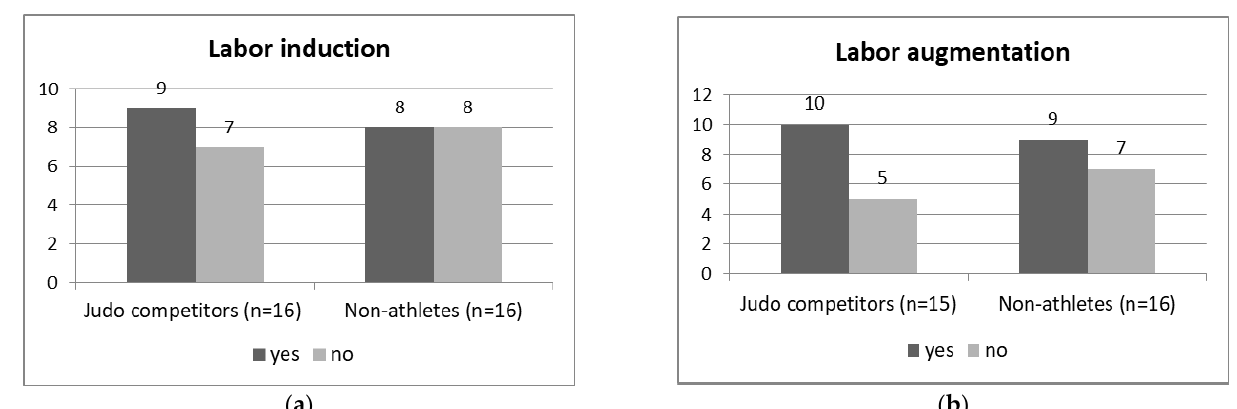
Figure 1. The numbers of first labor ( a ) induction [χ 2 with Yates correction (1) = 0, p = 1], and ( b ) augmentation [χ 2 with Yates correction (1) = 0.05, p = 0.82] in elite judo athletes and non-athlete controls.